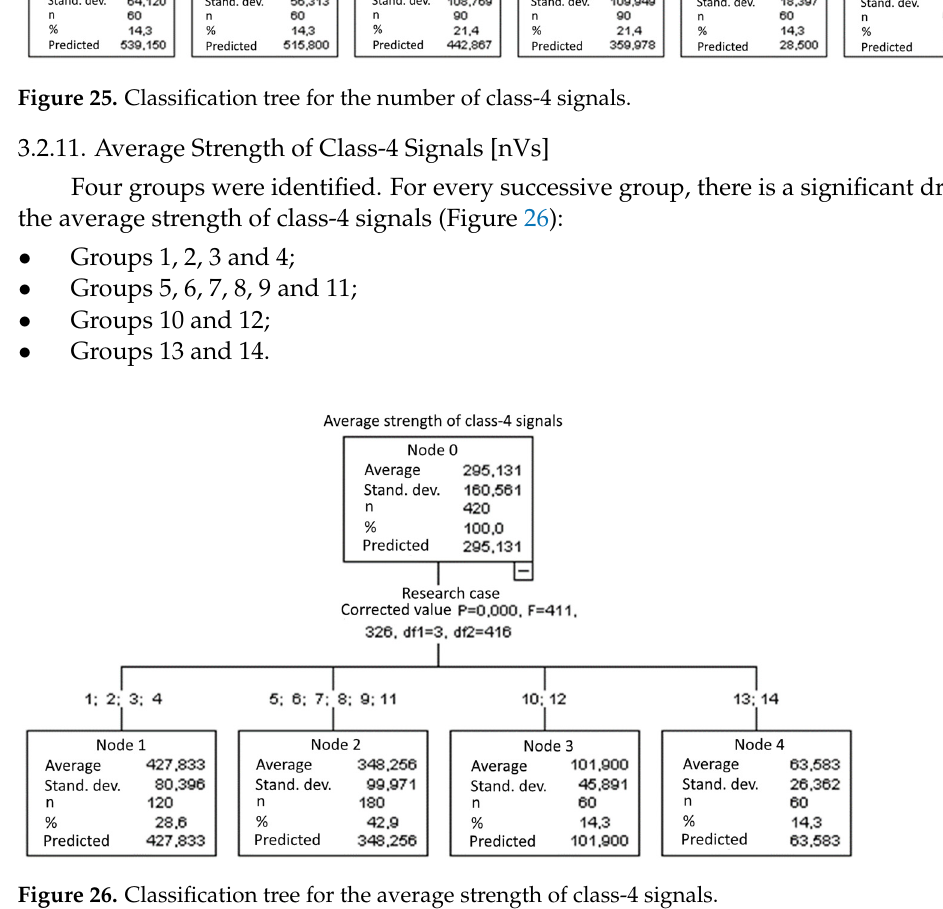
Figure 27. Classification tree for the average duration of class-4 signals. 3.2.13. Average Frequency of AE Events before Reaching F max [kHz] Five groups were identified. For every successive group, there is a significant drop in the average duration of AE events (Figure 28): •